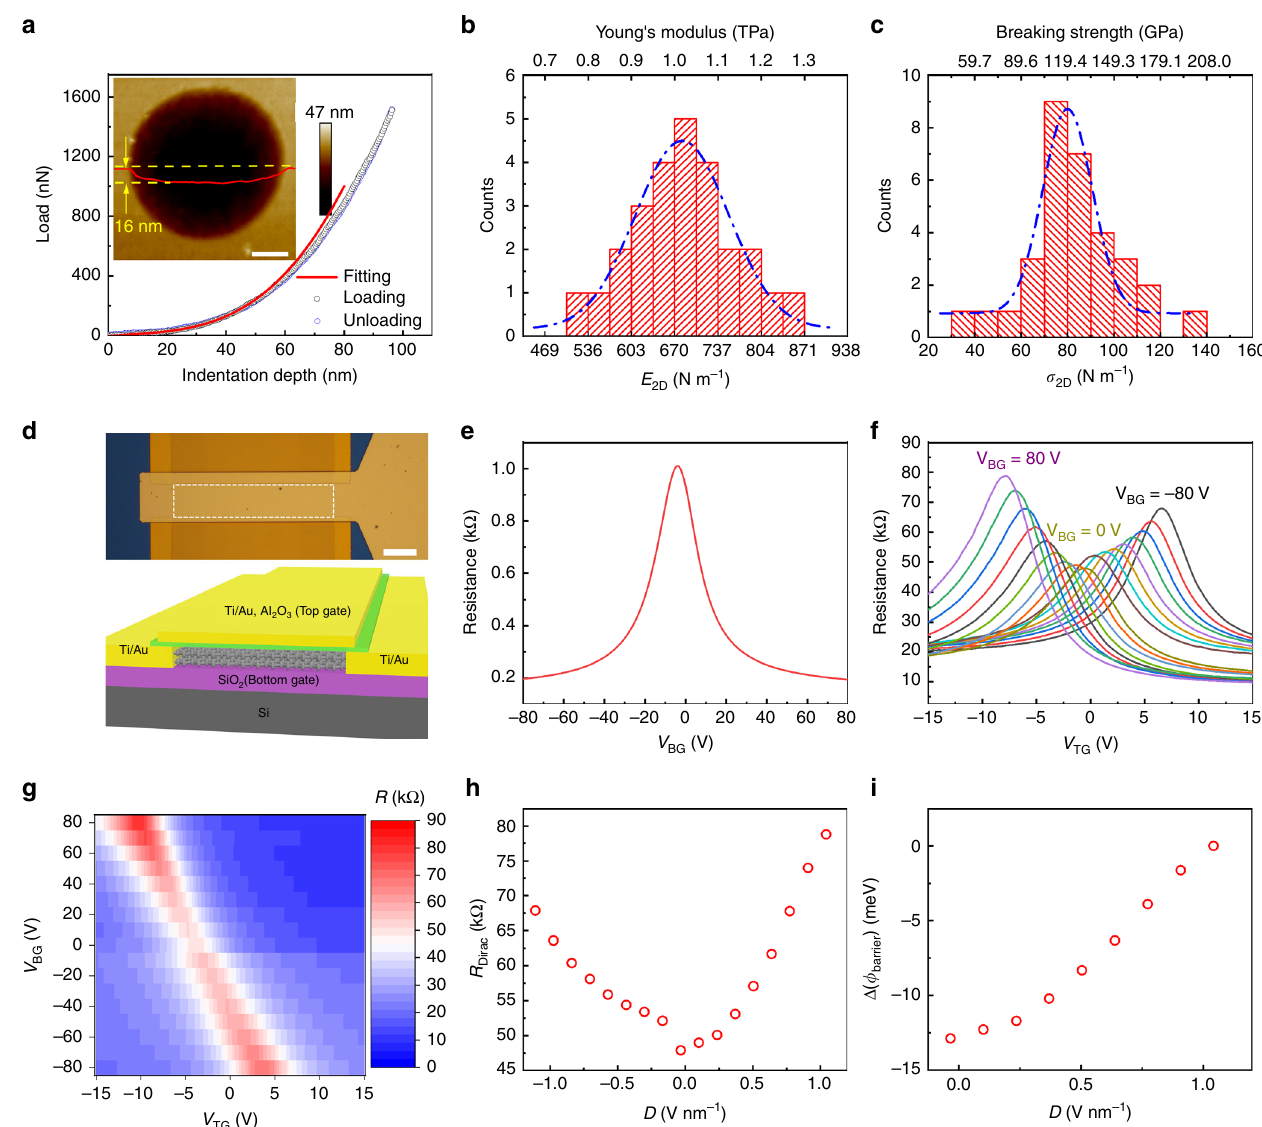
Fig. 3 Mechanical and electrical properties of the CVD-grown AB-BLG fi lms by interlayer epitaxy. a Typical force-displacement curves of an AB-BLG fi lm in AFM nanoindentation. The red line is the fi tting curve, and the inset is an AFM image of the suspended AB-BLG fi lm before indentation test and the height pro fi le (red line) along the dashed yellow line showing ~16 nm indentation in the hole. b , c Histograms of elastic stiffness ( b ) and breaking strength ( c ). Dashed lines represent Gaussian fi ts to the data. d Optical image (top) and illustration (bottom) of a dual-gate AB-BLG FET device. The dashed square in the optical image shows the AB-BLG channel (80 μ m × 20 μ m) underneath the top gate. The top-gate dielectric is 60 nm Al 2 O 3 , and the back-gate dielectric is 290 nm SiO 2 . e Resistance versus V BG curve measured at room temperature. f The room temperature transfer characteristics of a dual-gate AB-BLG FET. V BG is varied from − 80 to 80 V with step of 10 V. g Color plot of resistance as function of both V TG and V BG obtained from the data in ( f ). h Resistance at Dirac point under different electrical displacement, D . i Variation of Schottky barrier height, Δ ( ϕ barrier ), as a function of D , inferred